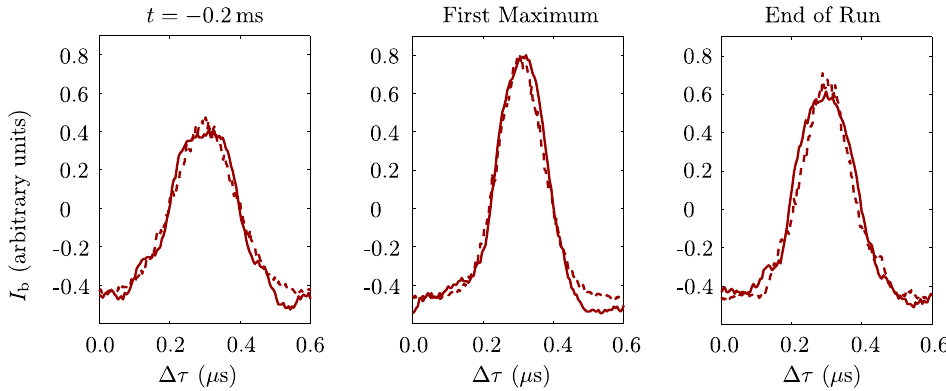
Beam current I for three different instants of time for run C (solid line: measurement; dotted line: simulation). b